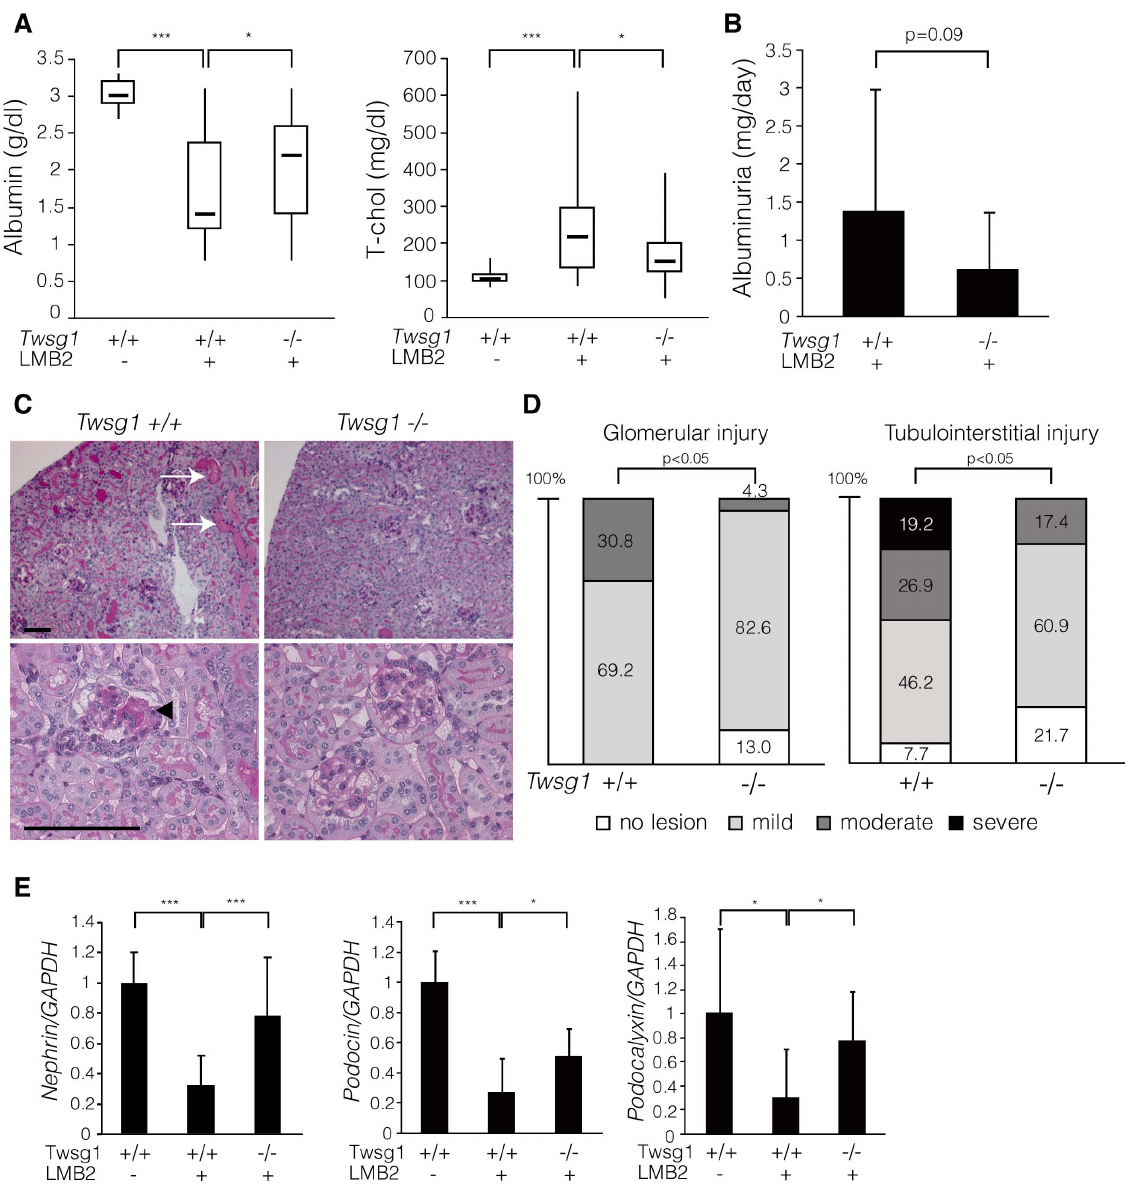
Figure 4. Twsg1 null mice were resistant to podocyte injury. ( A ) Twsg1 + / + :NEP25 and Twsg1 LacZ/LacZ :NEP25 mice were injected with immunotoxin and analyzed seven days later. While Twsg1 + / + :NEP25 mice injected with immunotoxin (Tswg1 + / + LMB2 + , n=30) showed decreased levels of serum albumin and increased levels of total cholesterol compared to the controls (Tswg1 + / + LMB2-, n=13), these changes in serum parameters were significantly attenuated in Twsg1 LacZ/LacZ :NEP25 mice (Tswg1 2 / 2 LMB2 + , n=24). Data are given in boxplots, in which the bottom and top of each box represent the 25th and 75th percentile, respectively, and the band near the middle of each box indicates the median. The ends of the whiskers represent the minimum and maximum of all data. ( B ) Urinary albumin levels were analyzed four days after the injection. Twsg1 LacZ/ LacZ :NEP25 mice (Tswg1 2 / 2 LMB2 + , n=17) showed lower levels of urinary albumin compared to Twsg1 + / + :NEP25 mice (Tswg1 + / + LMB2 + , n=15), although this difference was not statistically significant. Data are presented as means 6 SD. ( C ) Representative histological findings of both genotypes seven days after the injection. Histological changes such as tubular degeneration (arrows) and glomerulosclerosis (arrowhead) were less severe in Twsg1 LacZ/LacZ :NEP25 mice (Tswg1 2 / 2 ) than in Twsg1 + / + :NEP25 mice (Tswg1 + / + ). Scale bars: 100 m m. ( D ) Glomerular and tubulointerstitial injury was analyzed semi-quantitatively in both genotypes. The severity of both glomerular and tubulointerstitial damage was significantly lower in Twsg1 LacZ/LacZ :NEP25 mice (Tswg1 2 / 2 , n=23) than in Twsg1 + / + :NEP25 mice (Tswg1 + / + , n=26). ( E ) Quantitative real-time PCR analysis of podocyte- specific genes in the whole kidneys seven days after the injection. Expression levels of nephrin, podocin and podocalyxin were severely reduced due to the injection of the immunotoxin in Twsg1 + / + :NEP25 mice (Tswg1 + / + LMB2 + , n=15) compared to the controls (Tswg1 + / + LMB2-, n=6), whereas this reduction was significantly attenuated in Twsg1 LacZ/LacZ :NEP25 mice (Tswg1 2 / 2 LMB2 + , n=9). Data are presented as means 6 SD. *p , 0.05, ***p , 0.001.